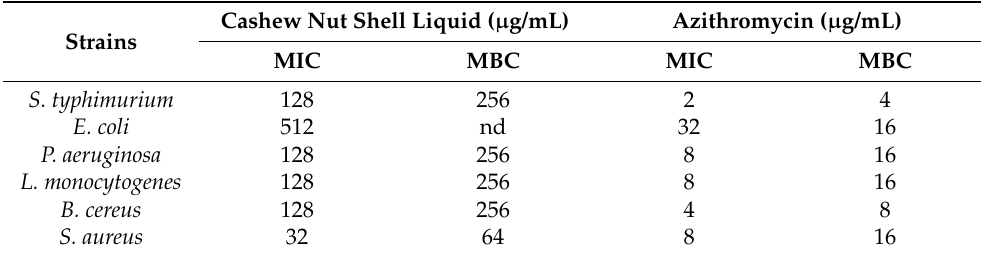
Table 2. Antimicrobial activity of bioactive films obtained from the incorporation of cashew nut shell liquid (CNSL) into a matrix of sodium alginate expressed as minimum inhibitory concentration (MIC) and minimum bactericidal concentration